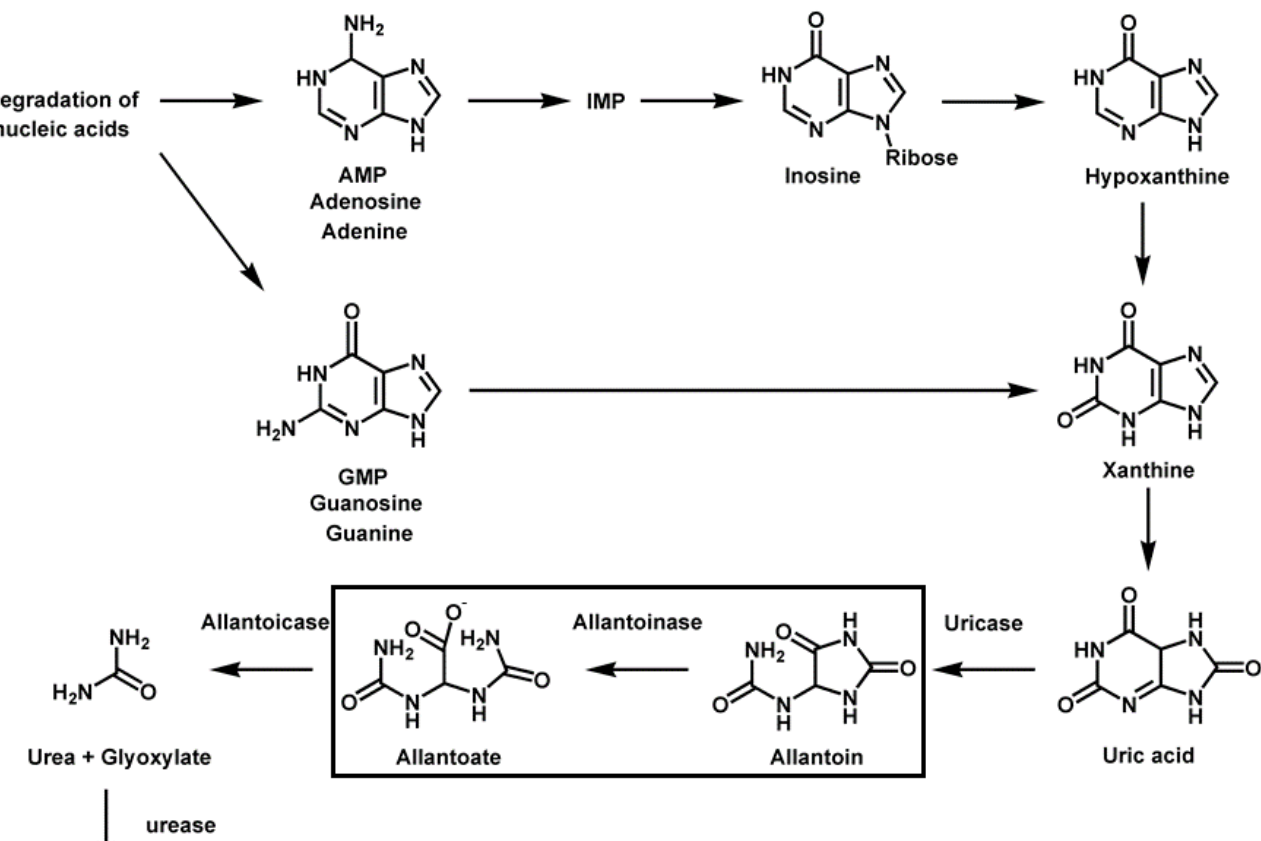
Figure 1. The pathways of purine nucleotide degradation. The chemical reaction catalyzed by allantoinase is highlighted. Allantoinase is a key enzyme for allantoin degradation. In the present study, we solved the crystal structure of E. coli BL21 allantoinase (EcALLase-BL21) at a resolution of 2.07 Å (PDB ID 8HFD) to obtain more information for structural analyses.